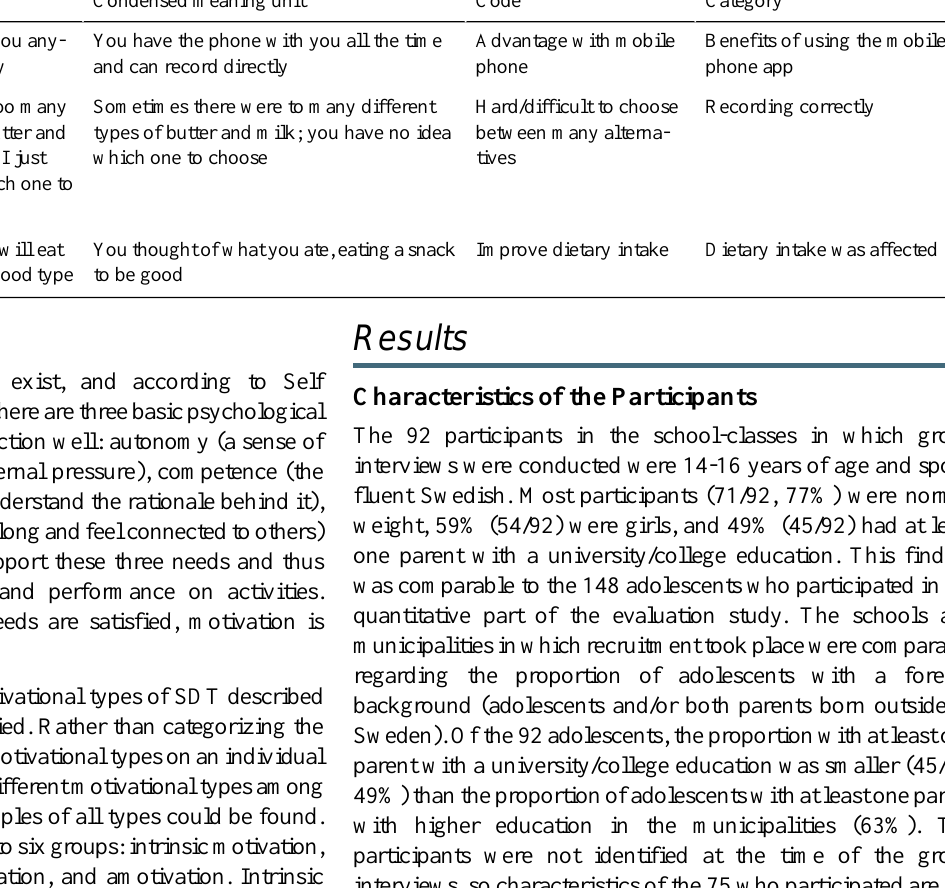
CategoryCodeCondensed meaning unitMeaning